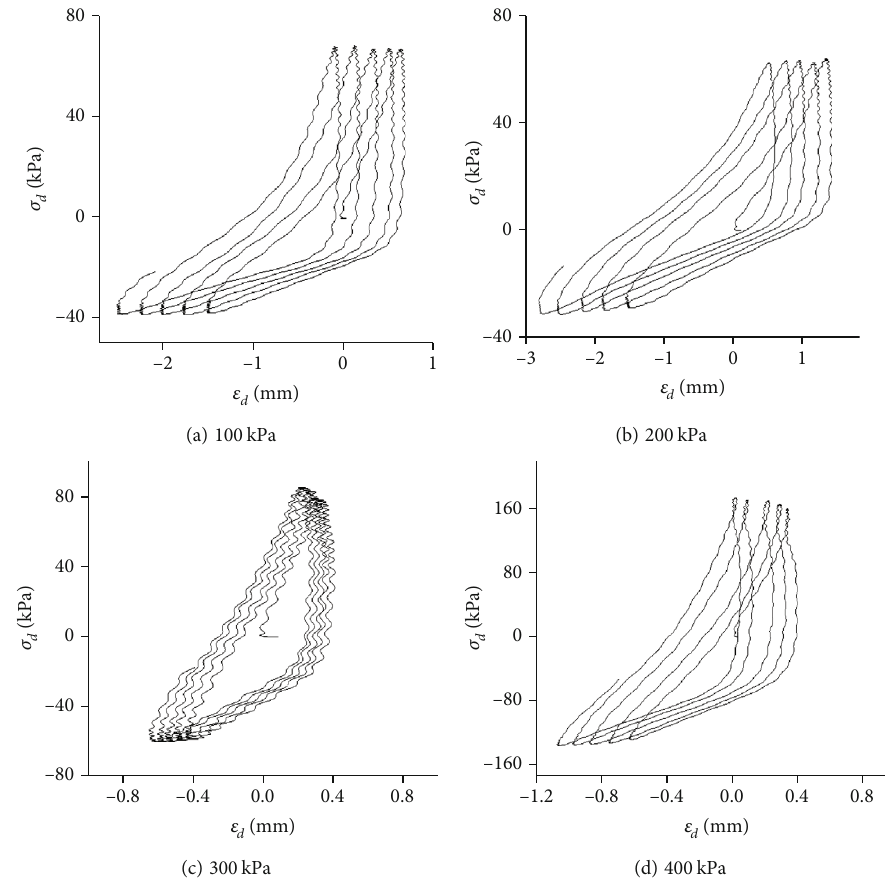
Figure 7: Load-deformation curves of calcareous sand under di ff erent e ff ective con fi ning